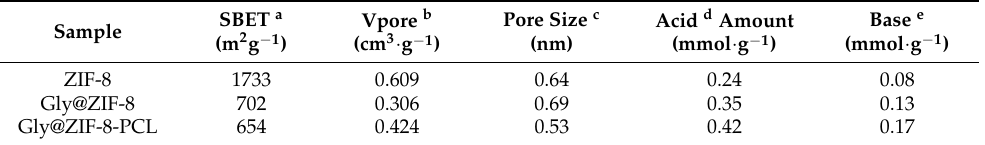
Table 1. Textural properties and acid and base amounts of the prepared